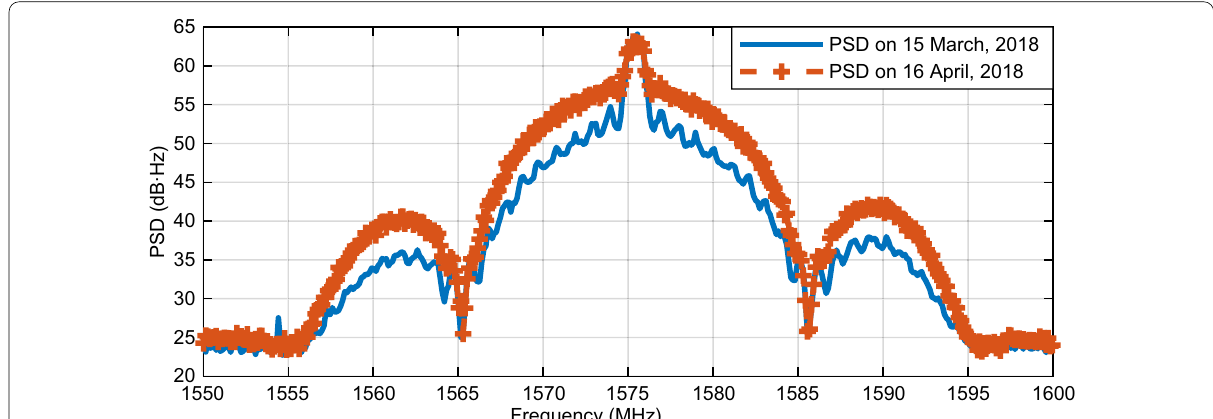
Fig. 5 The PSD of GPS Block IIF-10 L1 signal. The PSD is observed from the samples of a high-gain antenna